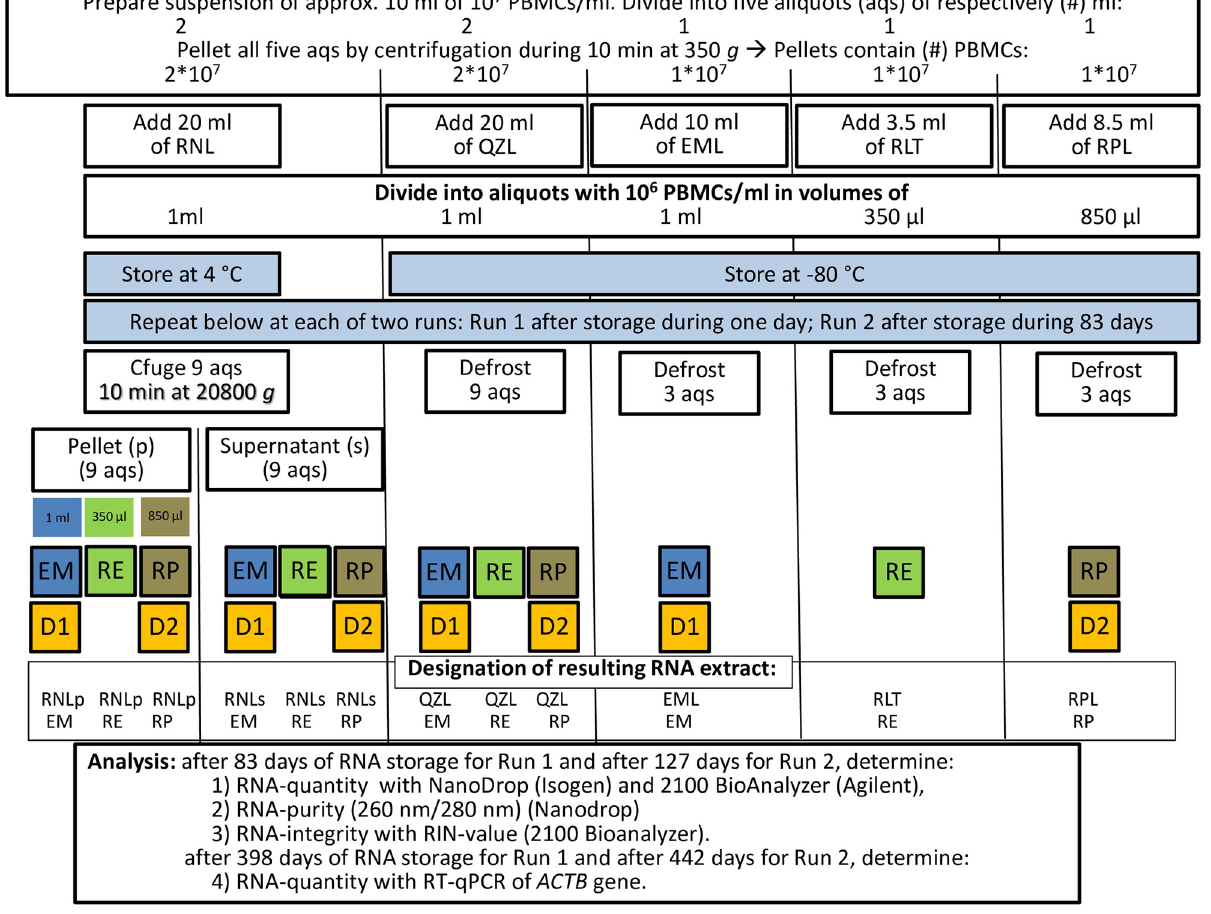
Fig 1. Study set up. Preparation of 10 6 PBMC aliquots, storage, RNA extraction and analysis of RNA quality, integrity and quantity. Storage medium: EML: NucliSENS easyMAG lysis buffer; QZL: QIAzol; RLT: RNeasy Mini Kit lysis buffer; RNLp: RNAlater pellet; RNLs: RNAlater supernatant; RPL: RiboPure RNA Purification Kit–blood lysis buffer. RNA extraction kits: EM: NucliSENS easyMAG; RE: RNeasy Mini Kit; RP: RiboPure RNA Purification Kit–blood. DNase treatment: D1, D2: as described in the M&M section. For the RE RNA Kit, DNase treatment was included during the extraction procedure, as described in the M&M